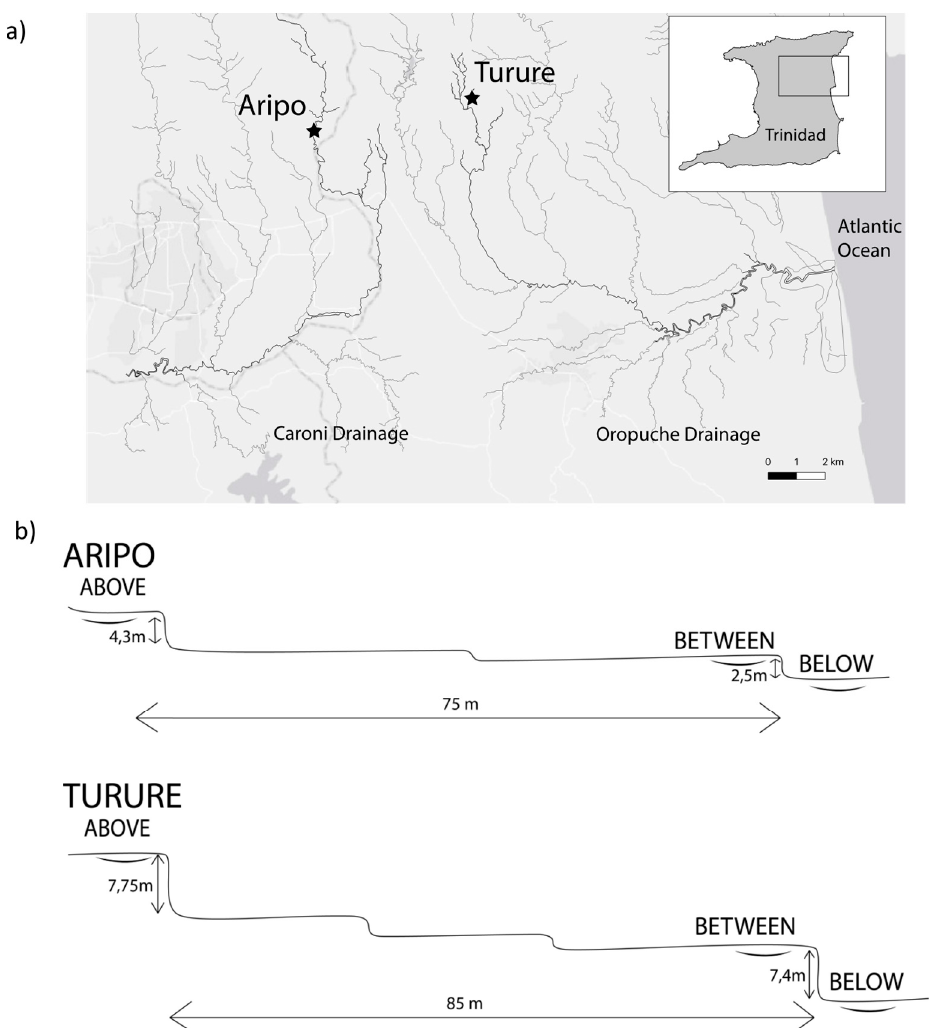
Figure 1. ( a ) Location of collection sites in the two rivers in the Northern Mountain range in Trinidad. ( b ) Profile for the two rivers showing the relative location and height of waterfalls in relation to the distance between them. Rivers flow from the left (upstream) to the right (downstream). Above, Between and Below represent the three collection sites per stream.